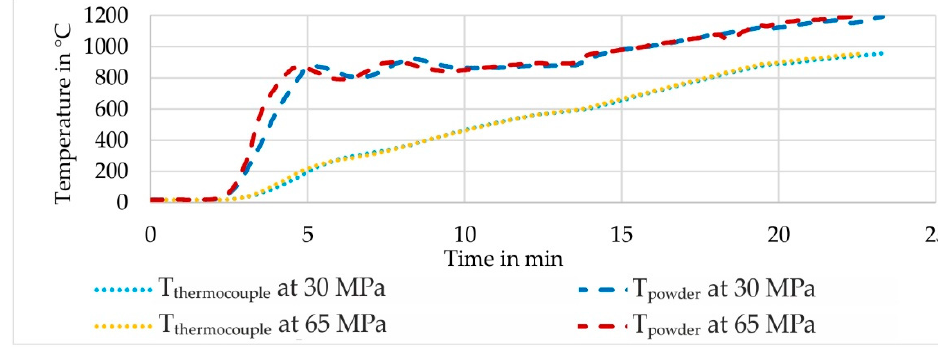
Figure 3. Temperature–time diagram of TNM to determine correction factors.